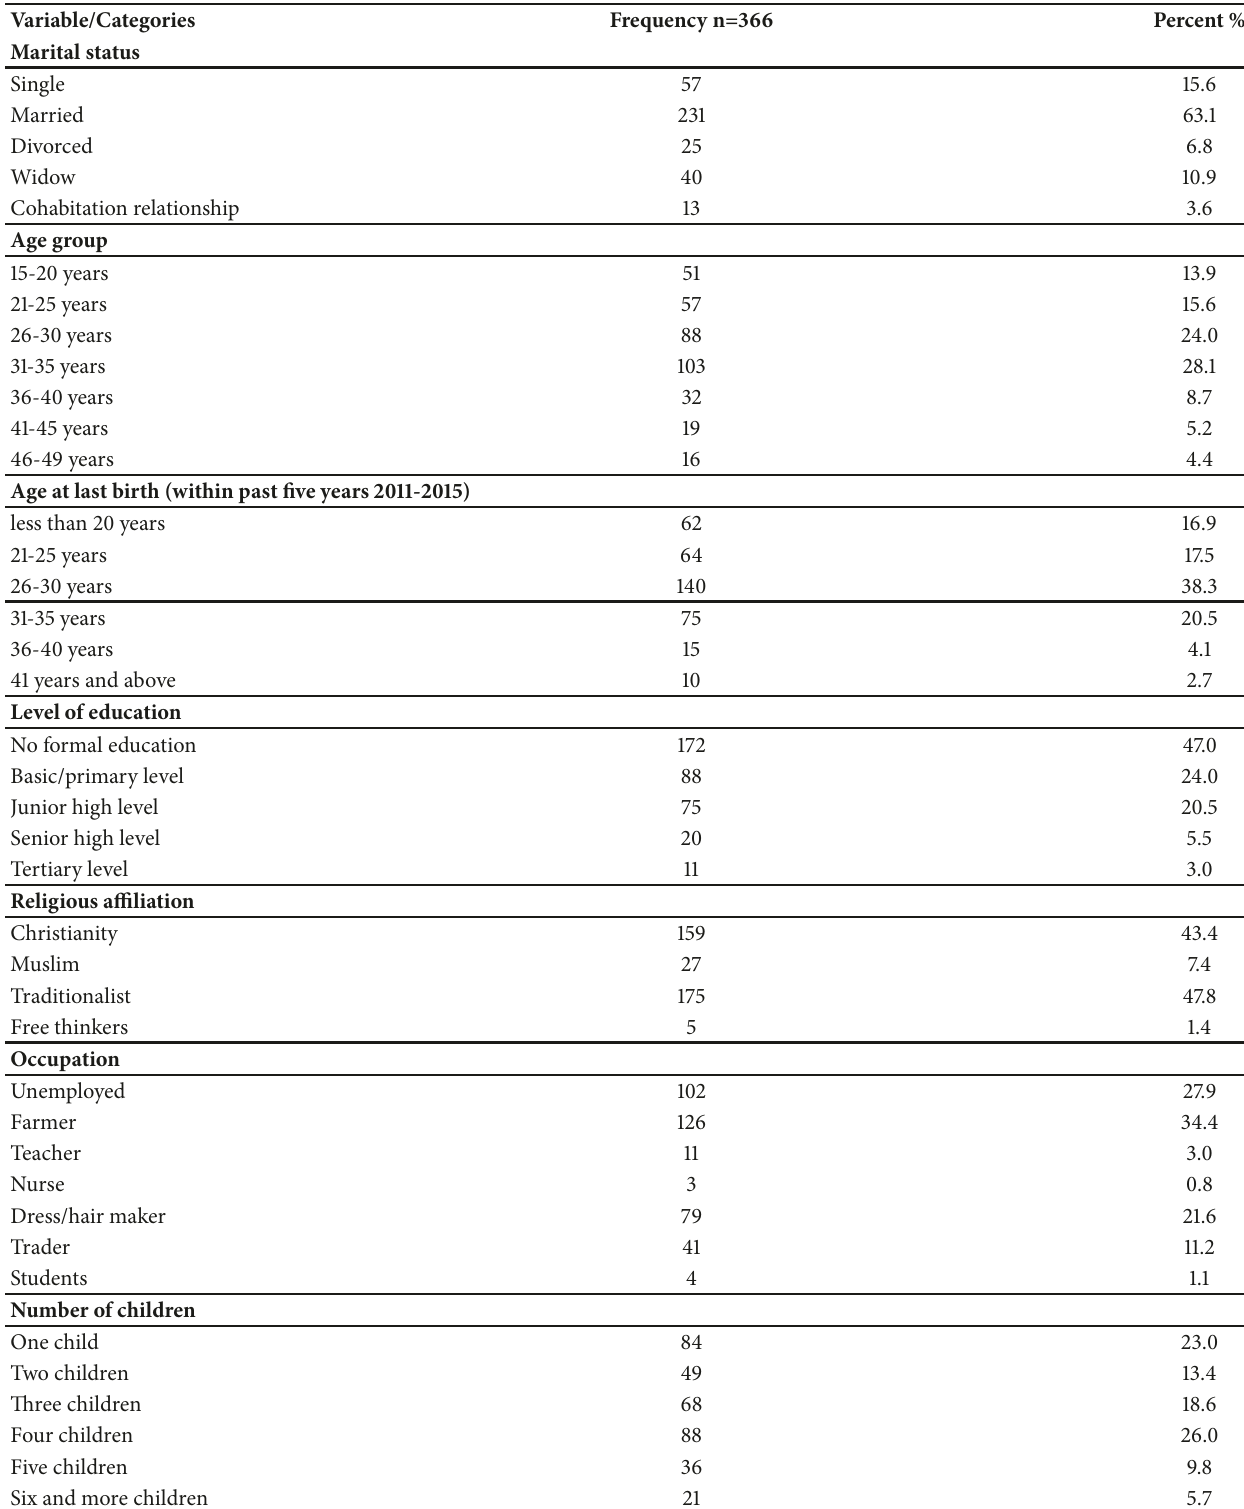
Table 2: Univariate analysis: sociodemographic characteristic of